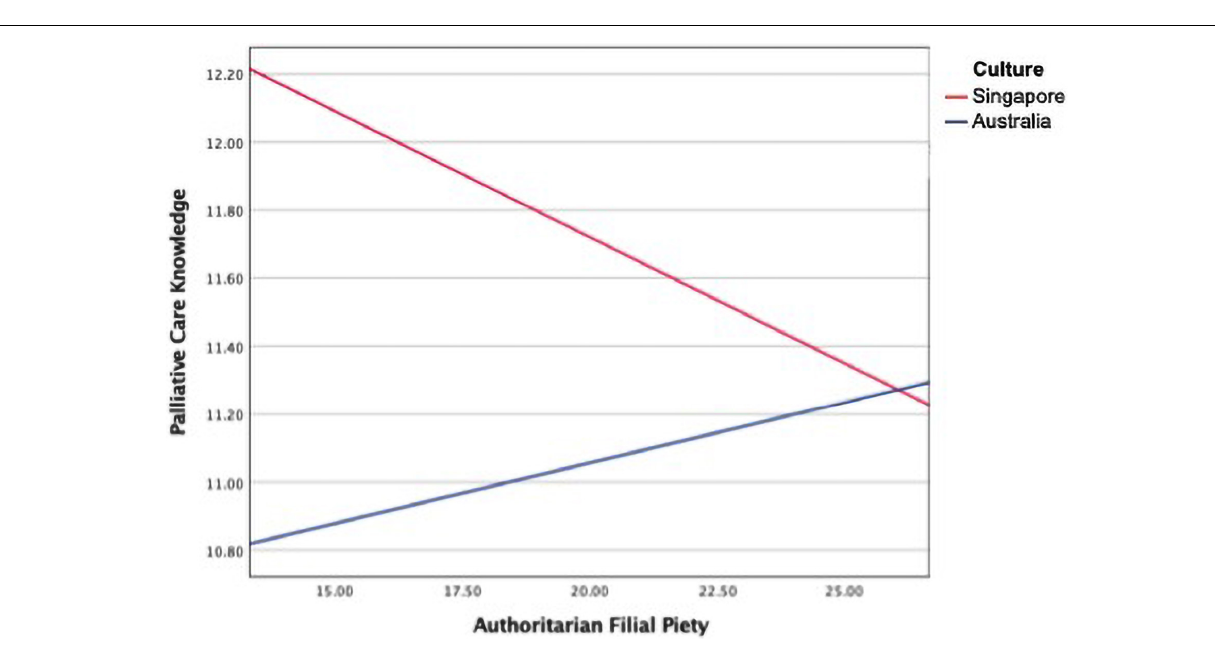
FIGURE 5 | The moderating effect of culture on the relationship between authoritarian filial piety and palliative care